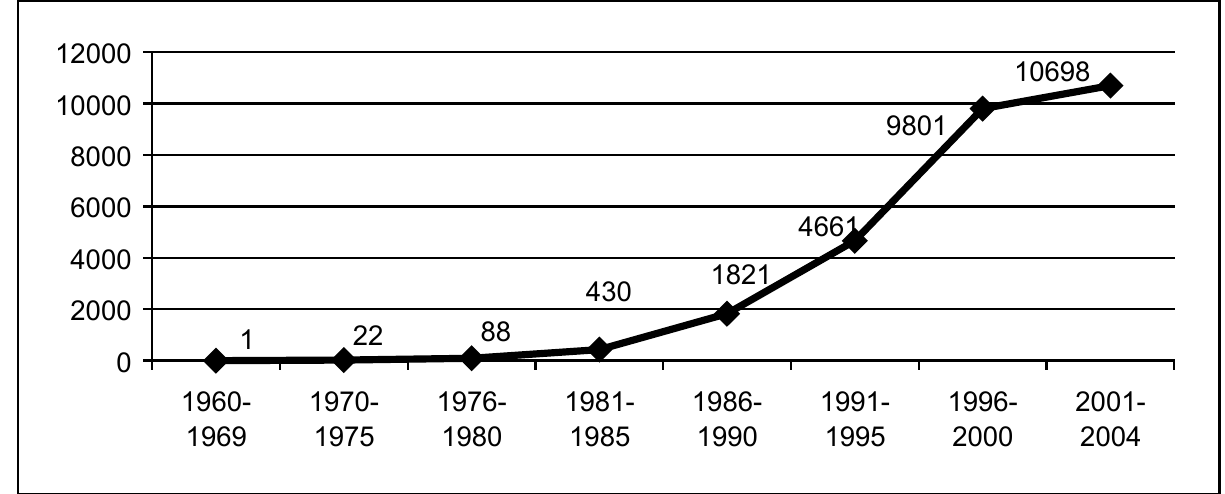
Figura 5 – Número de publicações científicas encontradas na pesquisa através do Medline, entre 1960 e 2004, onde o termo imuno-histoquímica aparece no título ou resumo dos trabalhos (limitando-se a estudos realizados em